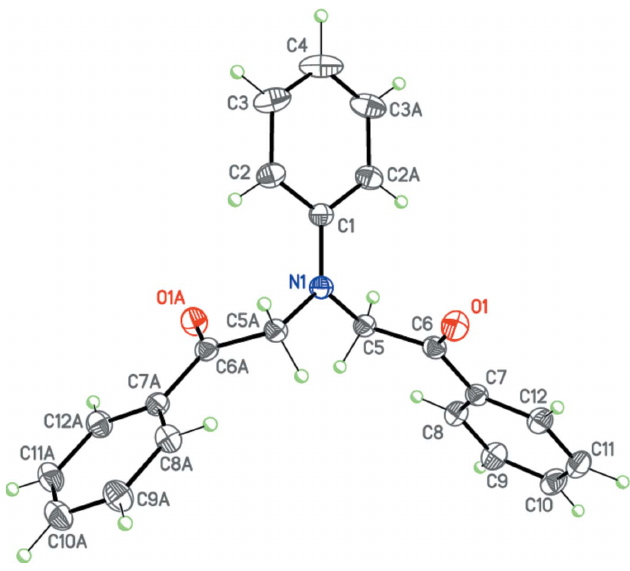
Figure 1 The molecular structure of the title compound. Displacement ellipsoids are drawn at the 50% probability